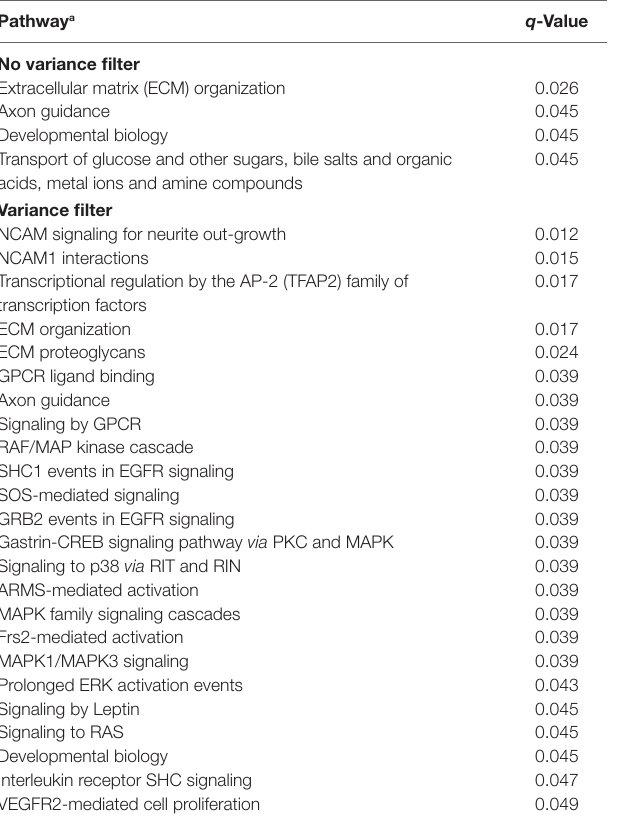
TaBle 3 | Pathway enrichment of differentially expressed genes identified using significance analysis of microarrays analysis with/ without a variance